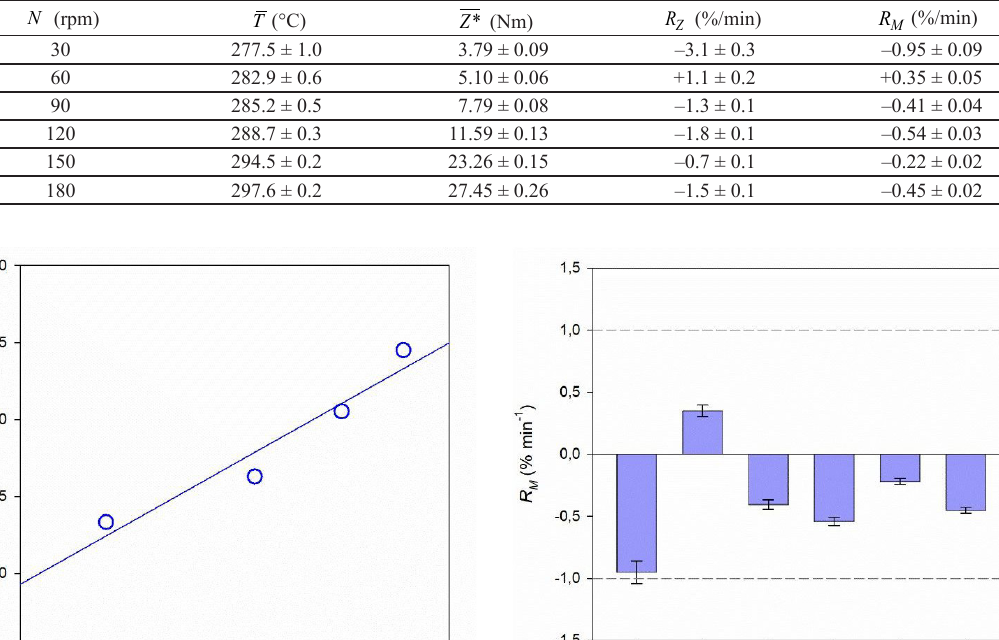
Figure 5. Average Temperature (a) and average adjusted torque (b) obtained at different rotor speeds for experiments carried out at 280 °C. Table 2. Estimated parameters for degradation rates or chain extension of PET processed in an internal mixer.